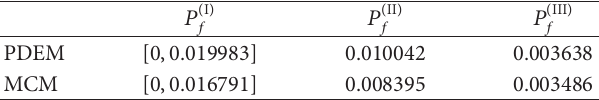
Figure 7: The membership function of 𝑃 𝑓 of Example 2. Table 4: The reliability indices of Example